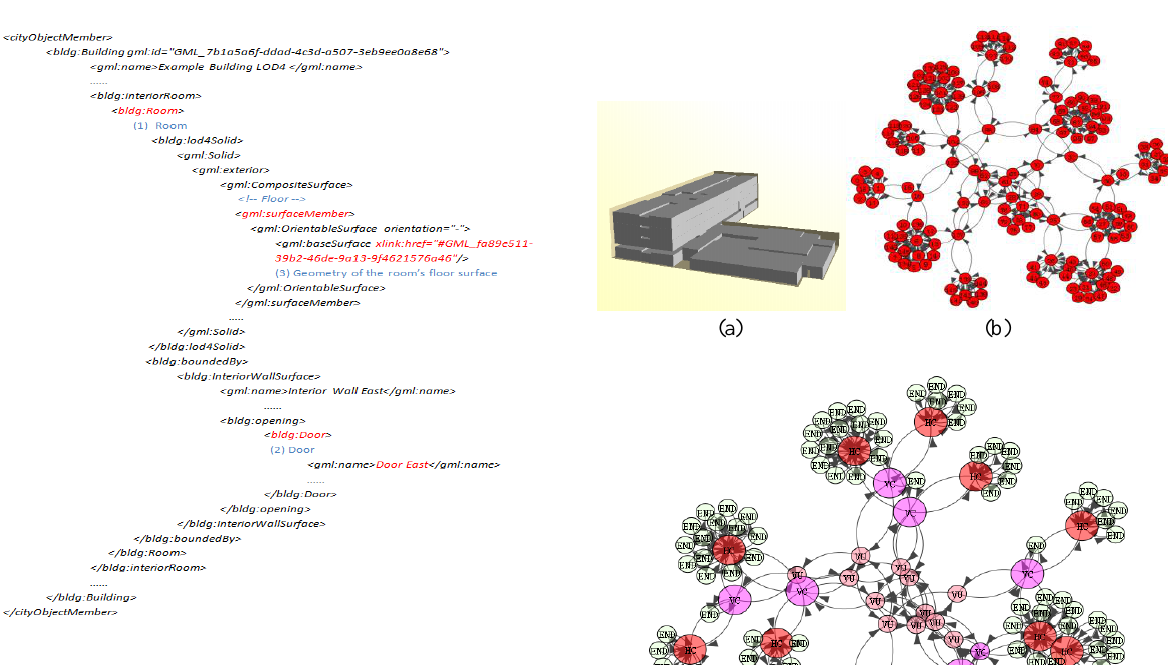
Figure 3. A standard CityGML example dataset in LOD4